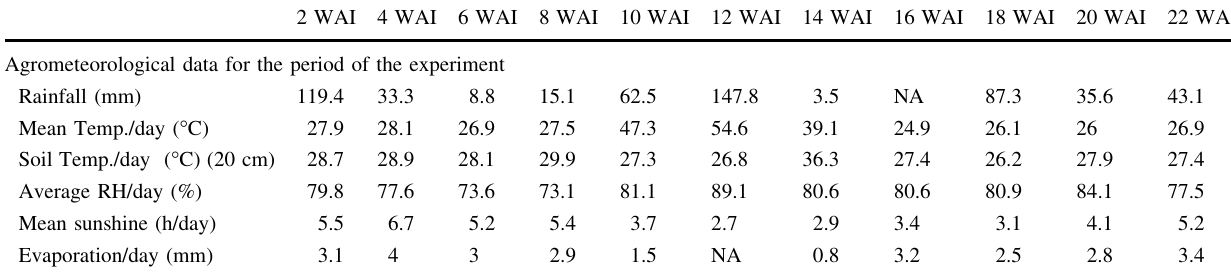
Table 1 Agrometeorological data for the period of the experiment